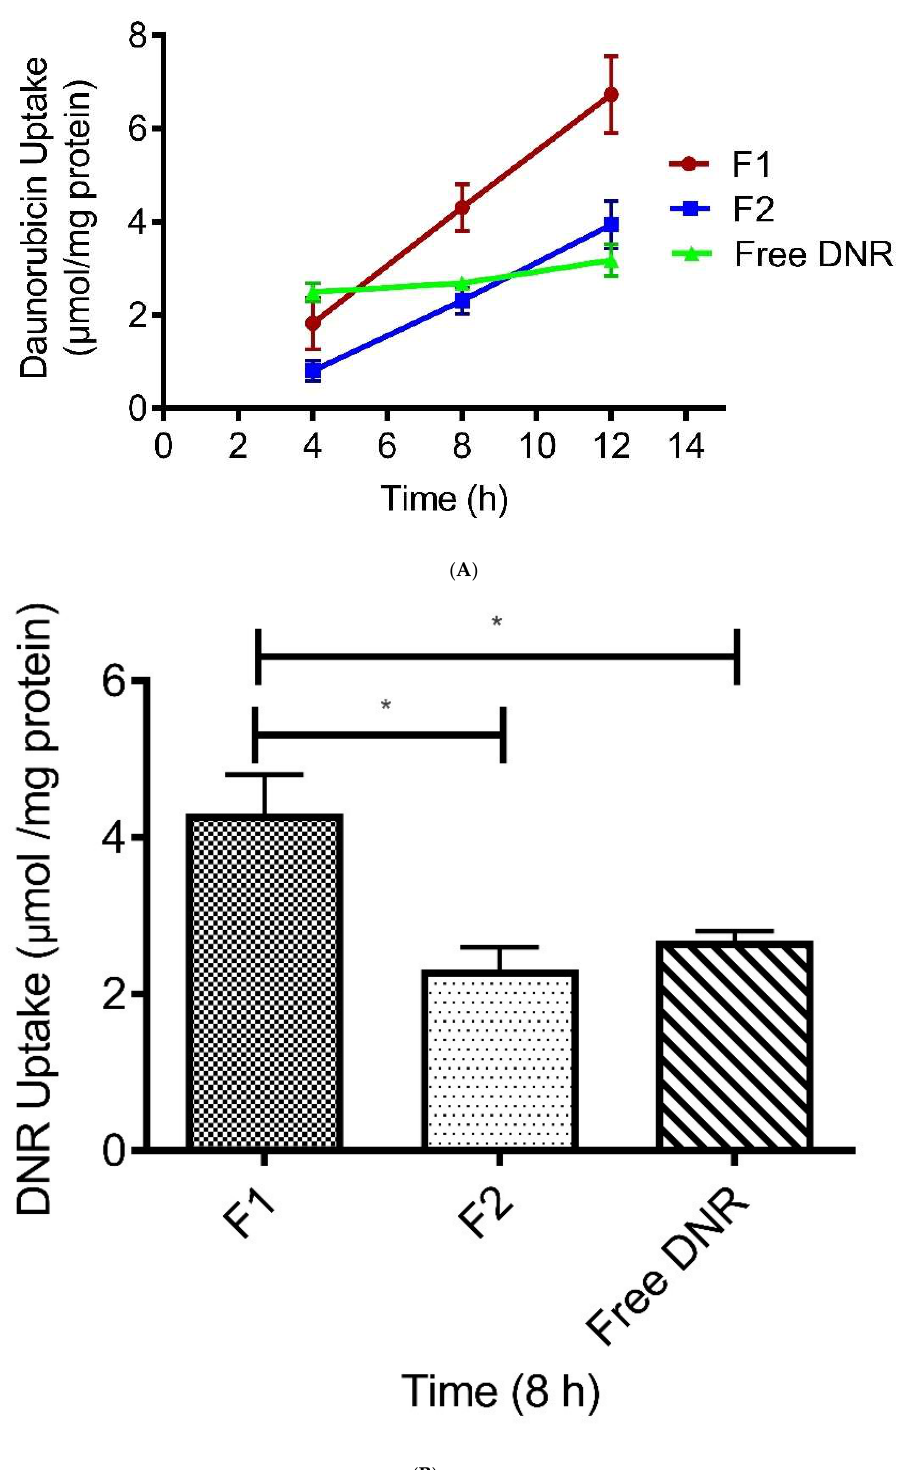
Figure 3. ( A ) Effect of pH-sensitive liposomes enriched with CL on DNR uptake by B16-BL6 cancer cell lines. Values represent mean ± SD, n = 3. ( B ). Effect of pH-sensitive liposomes enriched with CL on DNR uptake by B16-BL6 cancer cell lines. * indicates p < 0.05. Values represent mean ± SD, n = 3.